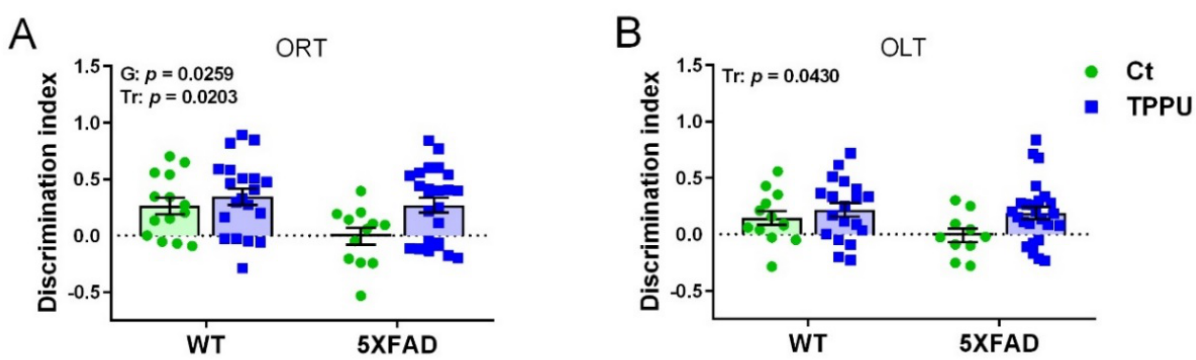
Figure 1. Cognitive testing in 2-month-old WT and 5XFAD mice from litters with maternal TPPU treatment or control (Ct). Breeding WT female mice were mated to 5XFAD male mice and dosed with 5 mg/kg/day of TPPU or vehicle during pregnancy and lactation. ( A ) Object recognition test (ORT); ( B ) object location test. Experimental maternal treatment: Ct (green circles), TPPU (blue squares); mouse genotype: WT (wild-type mice), 5XFAD (AD 5XFAD transgenic strain). Values are mean ± SEM of male and female mice (( A ) n = 12 − 20; ( B ) n = 10 − 25). Statistics: two-way ANOVA. There was a significant effect of the treatment factor (Tr) in ( A , B ) and of genotype factor (G) in ( B ). p values of the significant factors are indicated in the corresponding graphs.